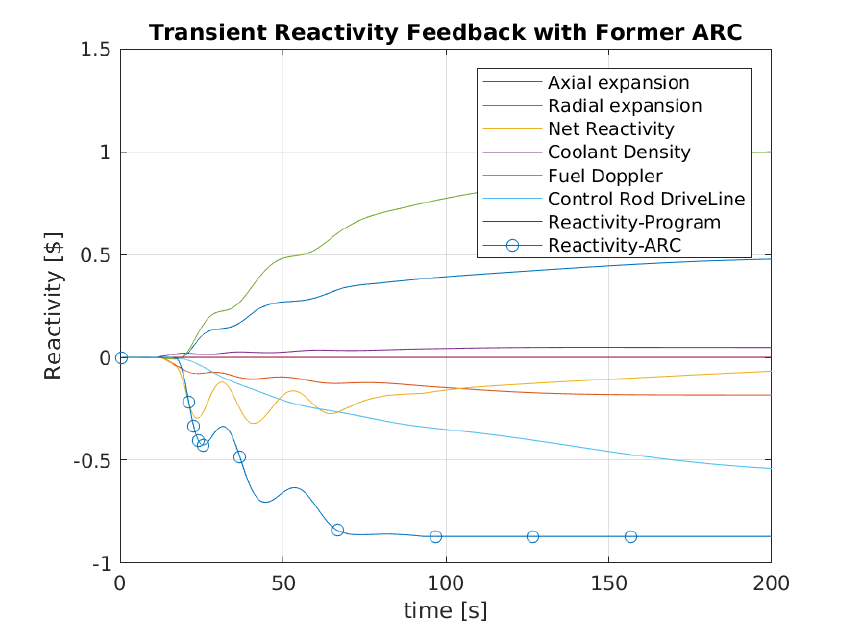
Figure 5: Response to a ULOF accident in ABR core with the standard ARC